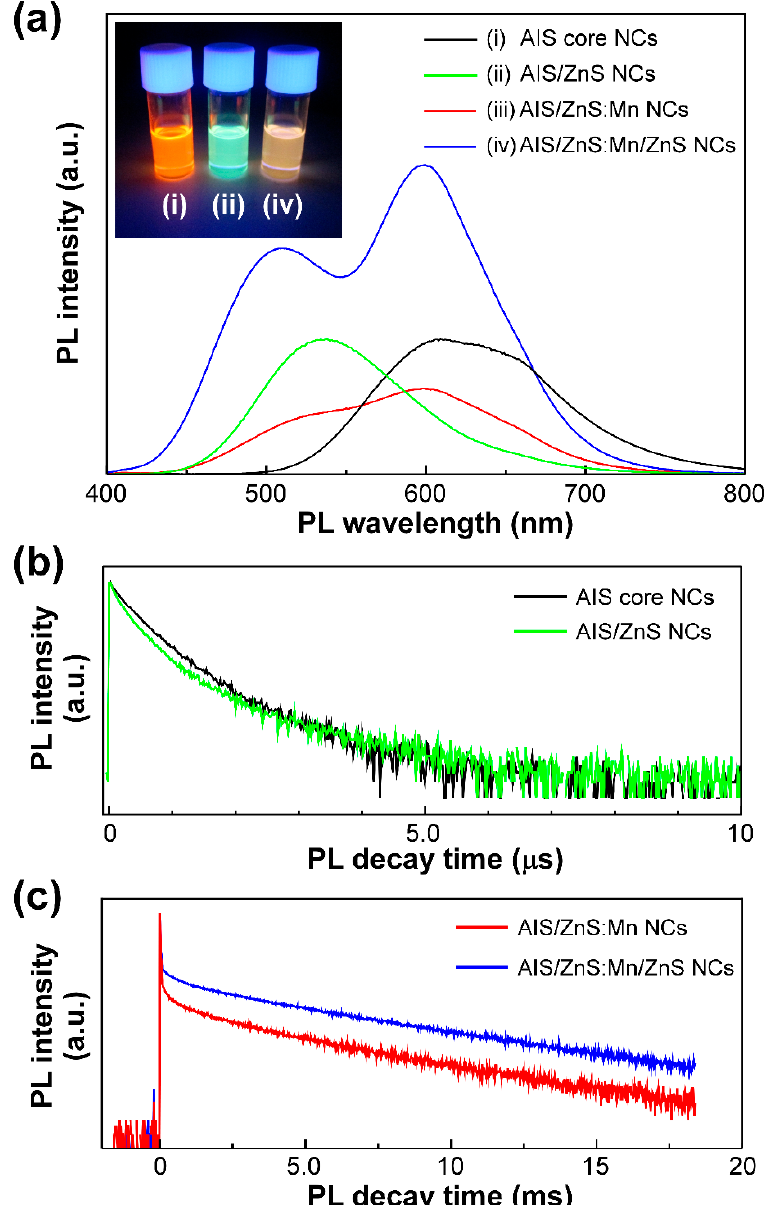
Figure 2. ( a ) PL spectra of solutions of AIS NCs (i: black), AIS/ZnS NCs (ii: green), AIS/ZnS:Mn NCs (iii: red), and AIS/ZnS:Mn/ZnS NCs (iv: blue) by optical excitation with 365 nm light. The inset represents the PL color image of solutions of AIS NCs, AIS/ZnS NCs, and AIS/ZnS:Mn/ZnS NCs. ( b ) PL decay curves of solutions of AIS NCs and AIS/ZnS NCs by optical excitation with 365 nm light. The PL decay measurements of AIS NCs and AIS/ZnS NCs were detected at 608 nm and 538 nm, respectively. ( c ) PL decay curves of solutions of AIS/ZnS:Mn NCs and AIS/ZnS:Mn/ZnS NCs by optical excitation with 365 nm light. The PL decay measurements of both AIS/ZnS:Mn NCs and AIS/ZnS:Mn/ZnS NCs were detected at 600 nm.